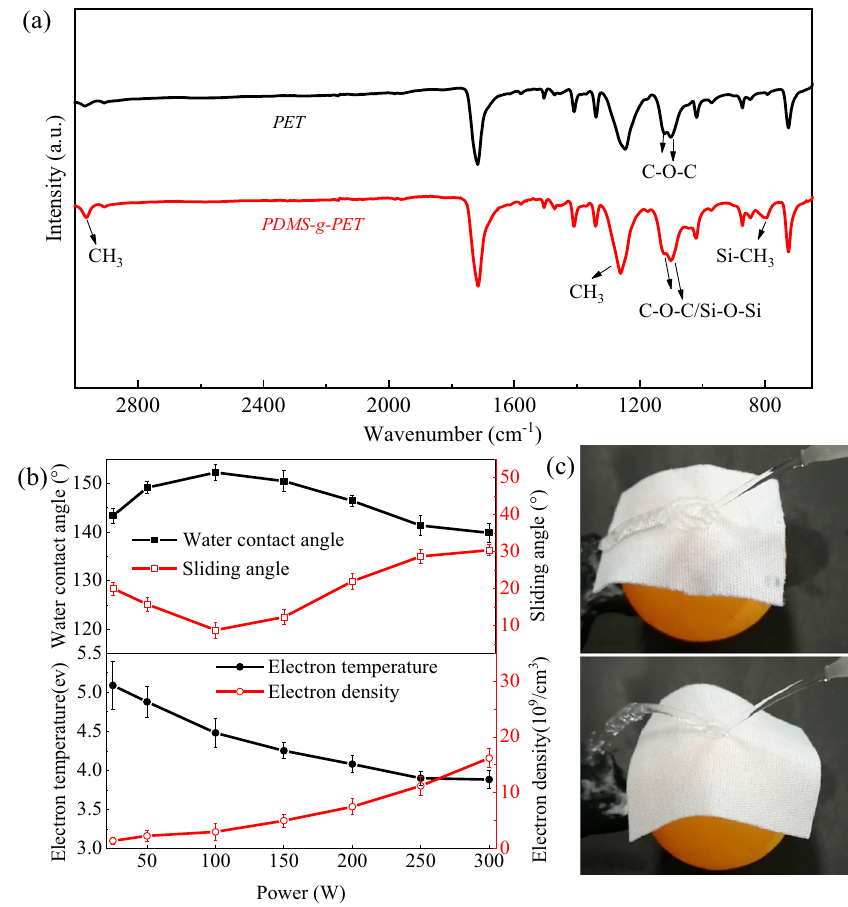
Figure 1: ( a ) The ATR - FTIR spectrum of the samples before and after treatment. ( b ) The water repellency of PET samples and the corre - sponding electron temperature and electron density under di ff erent powers. ( c ) The image of water contact with PET ( top ) and PDMS - g - PET ( below ) fabrics